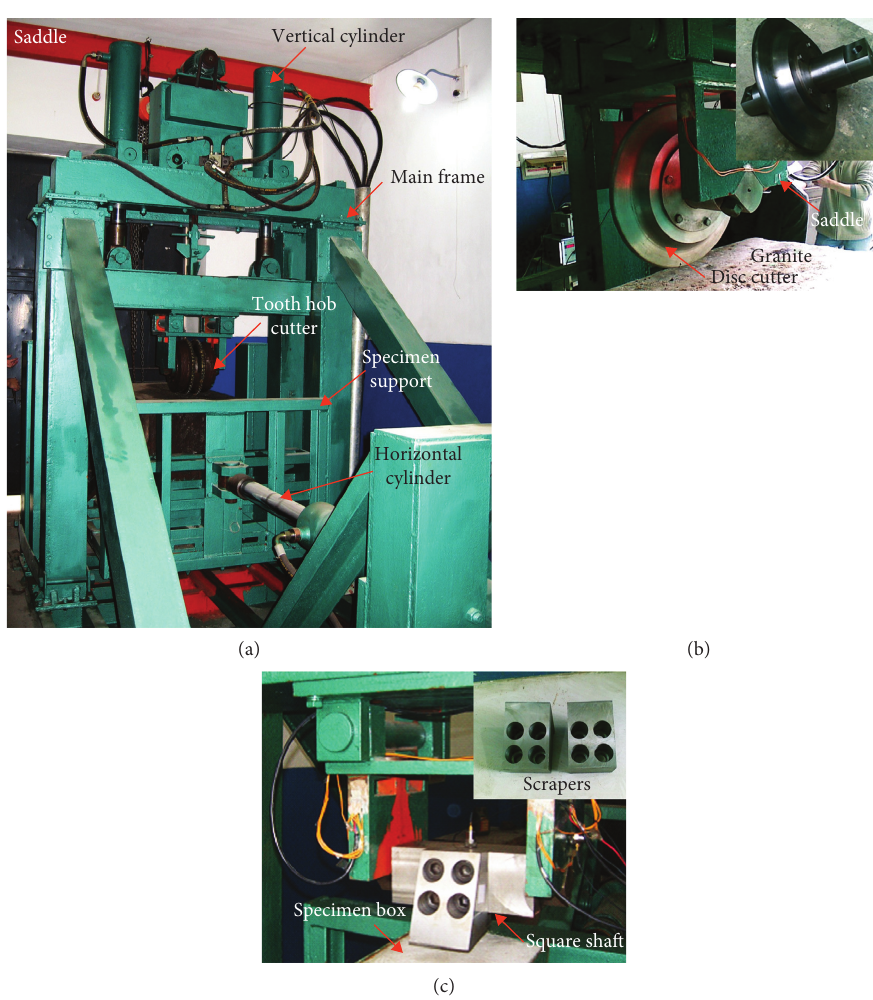
Figure 2: (a) main frame of LCM; (b) disc cutter; (c) two